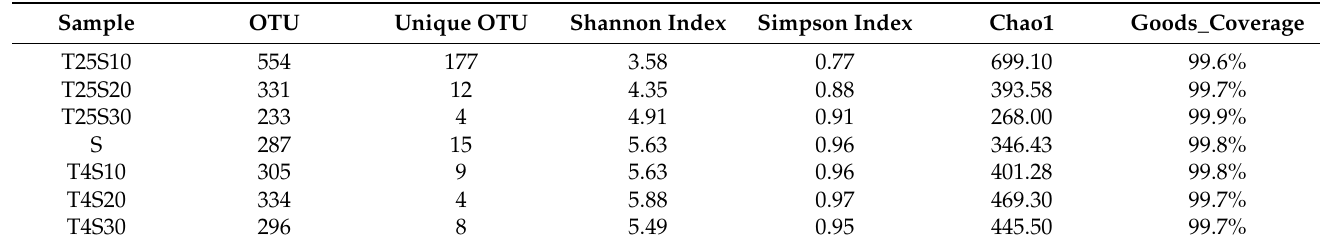
Table 1. High-throughput sequencing library information of bacterial and archaea 16S rRNA sequences from the salted kelp samples under different preservation conditions.